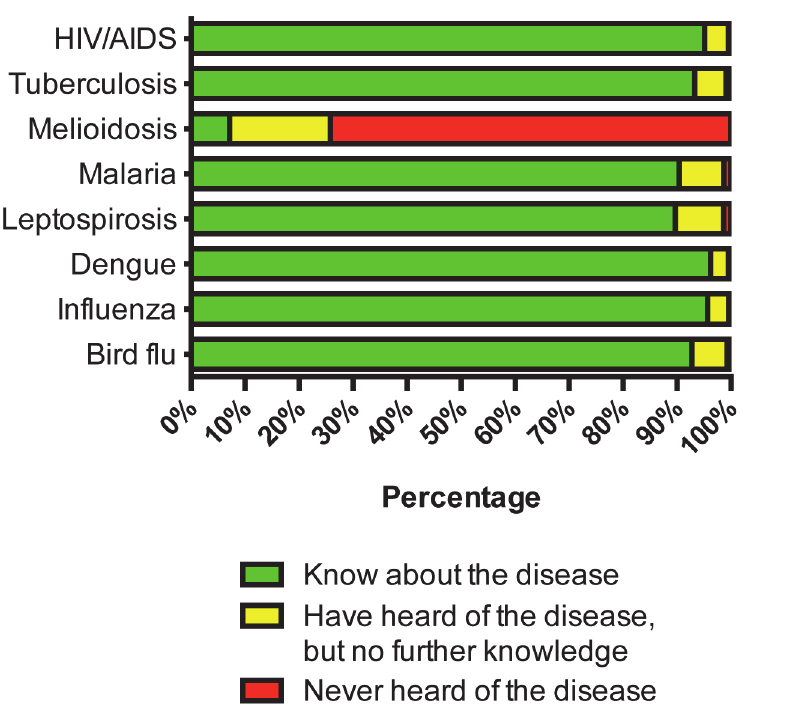
Fig 1. Awareness of common infectious diseases in Thailand (n =